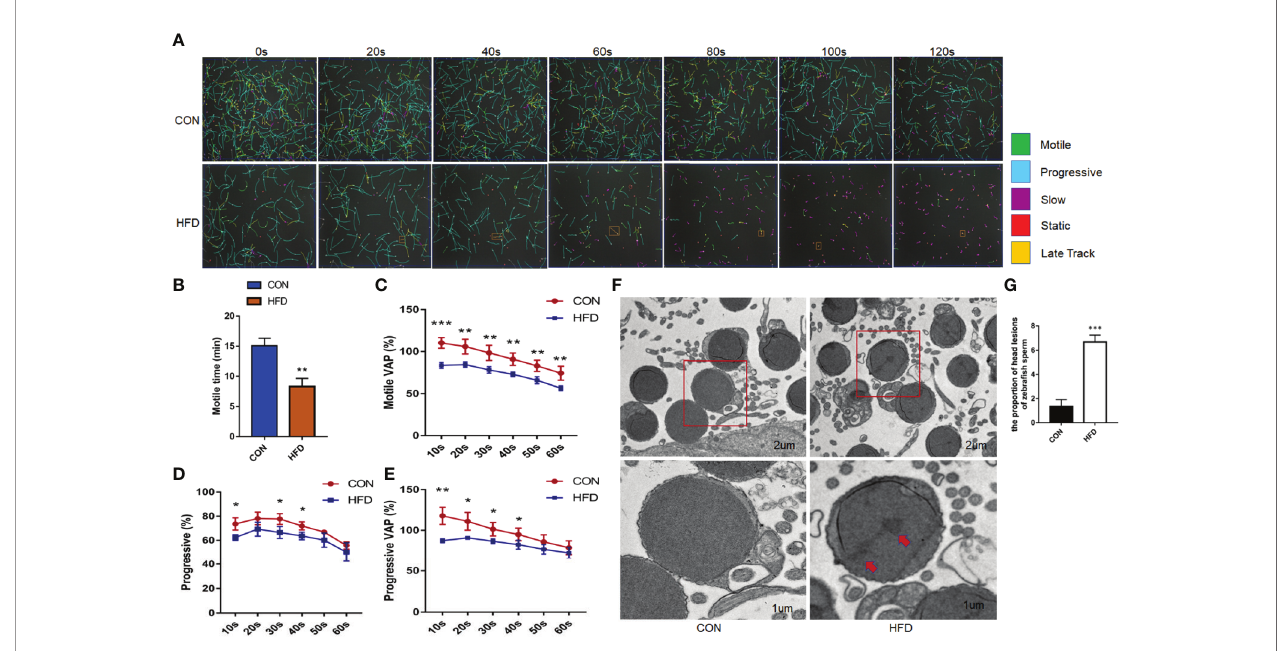
FIGURE 2 | Effects of obesity on the sperm motility of zebra fi sh. (A) Intuitive CASA image of zebra fi sh sperm movement under a microscope. (B) Sperm MOT between the two groups. (C – E) Percentage of motile VAP and progressive VAP (%) of adult zebra fi sh. (F) Comparison of sperm morphology between the two groups under the electron microscope. (G) The obese group had lesions on the head of the sperm as shown by the red arrow. Data represent mean ± SME (n = 6). *, ** and *** at P < 0.05, P < 0.01 and P < 0.001,